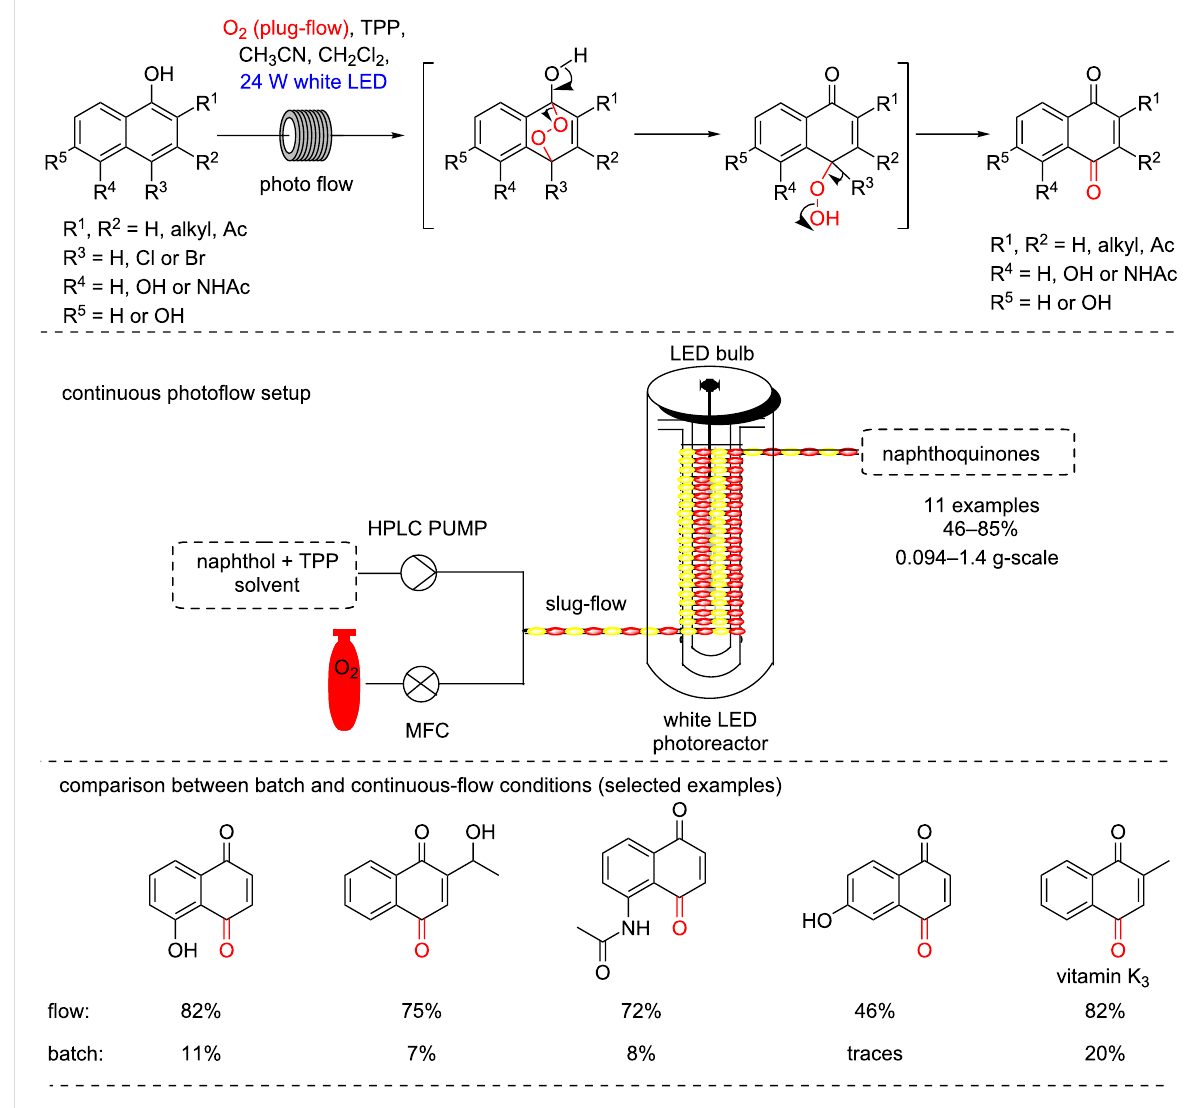
Scheme 36: Photocatalyzed preparation of